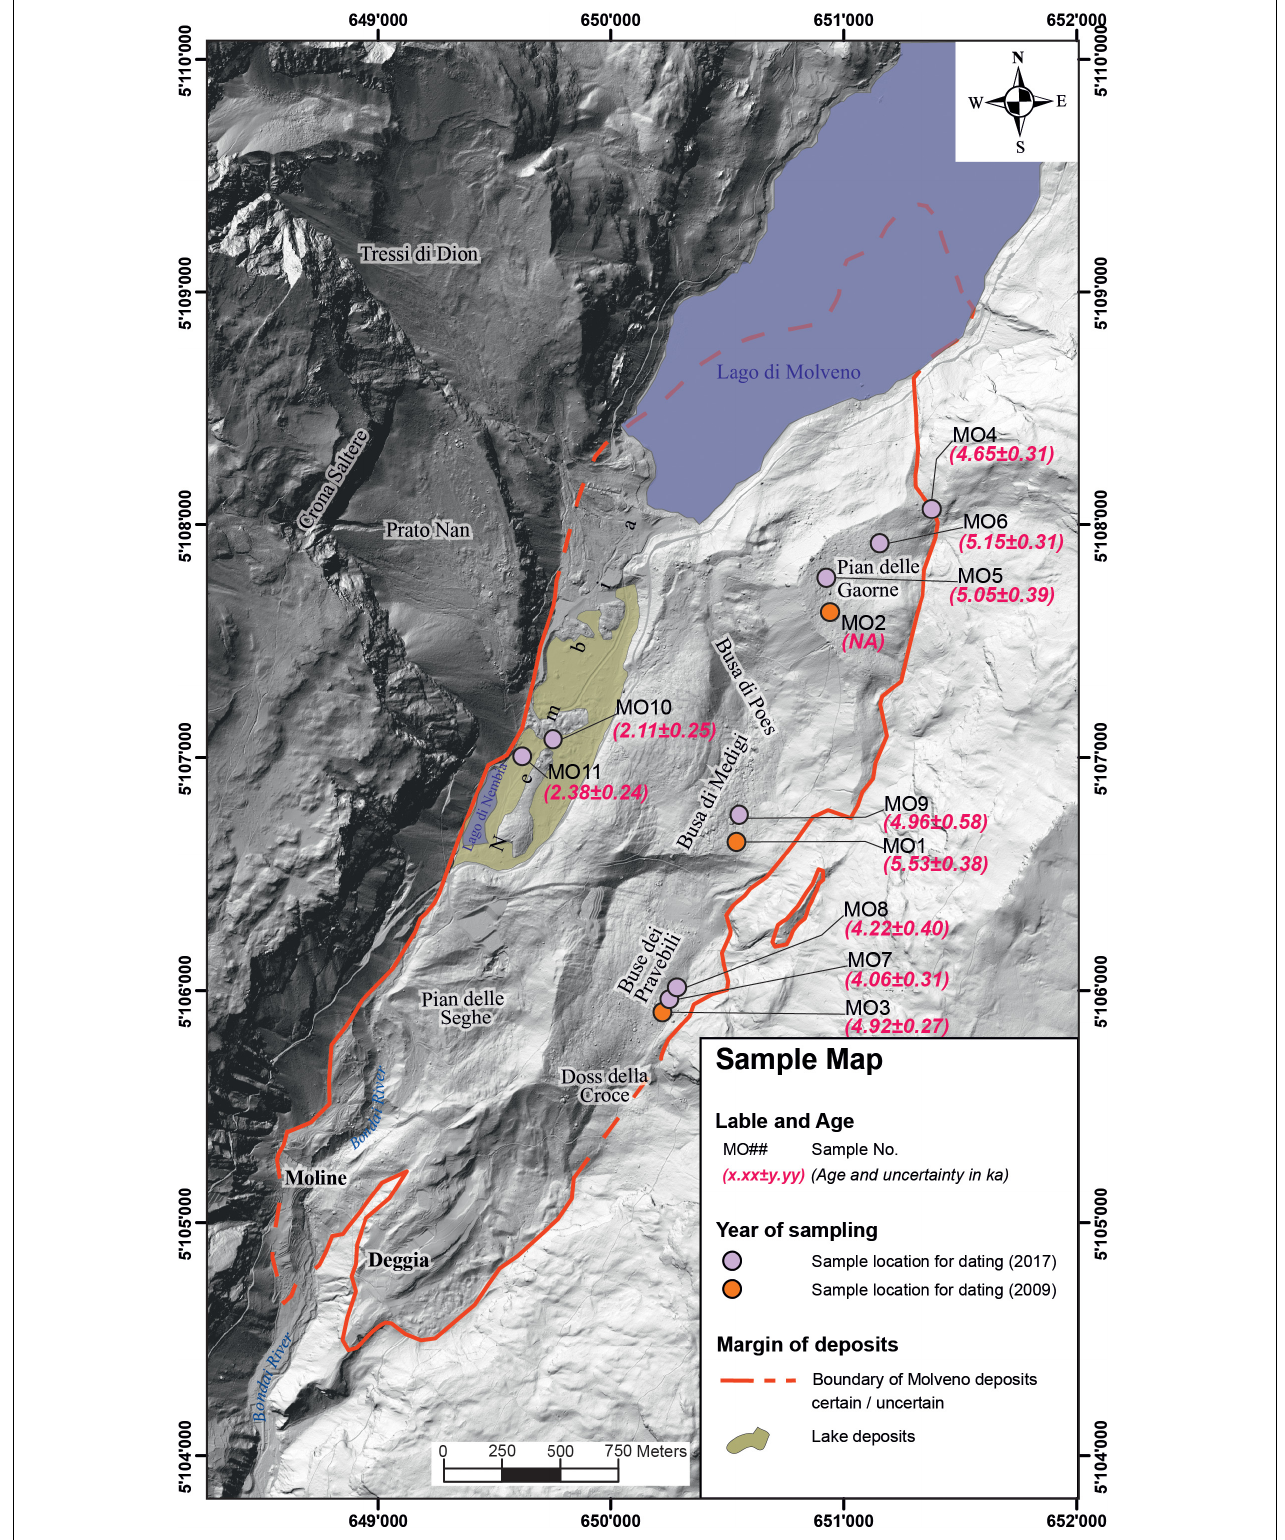
FIGURE 5 | Sample and 36 Cl exposure age map. All samples dated are shown in this figure (MO02 could not be dated due to too high 36 S counts during AMS). Coordinate system: WGS 1984 UTM Zone 32N.